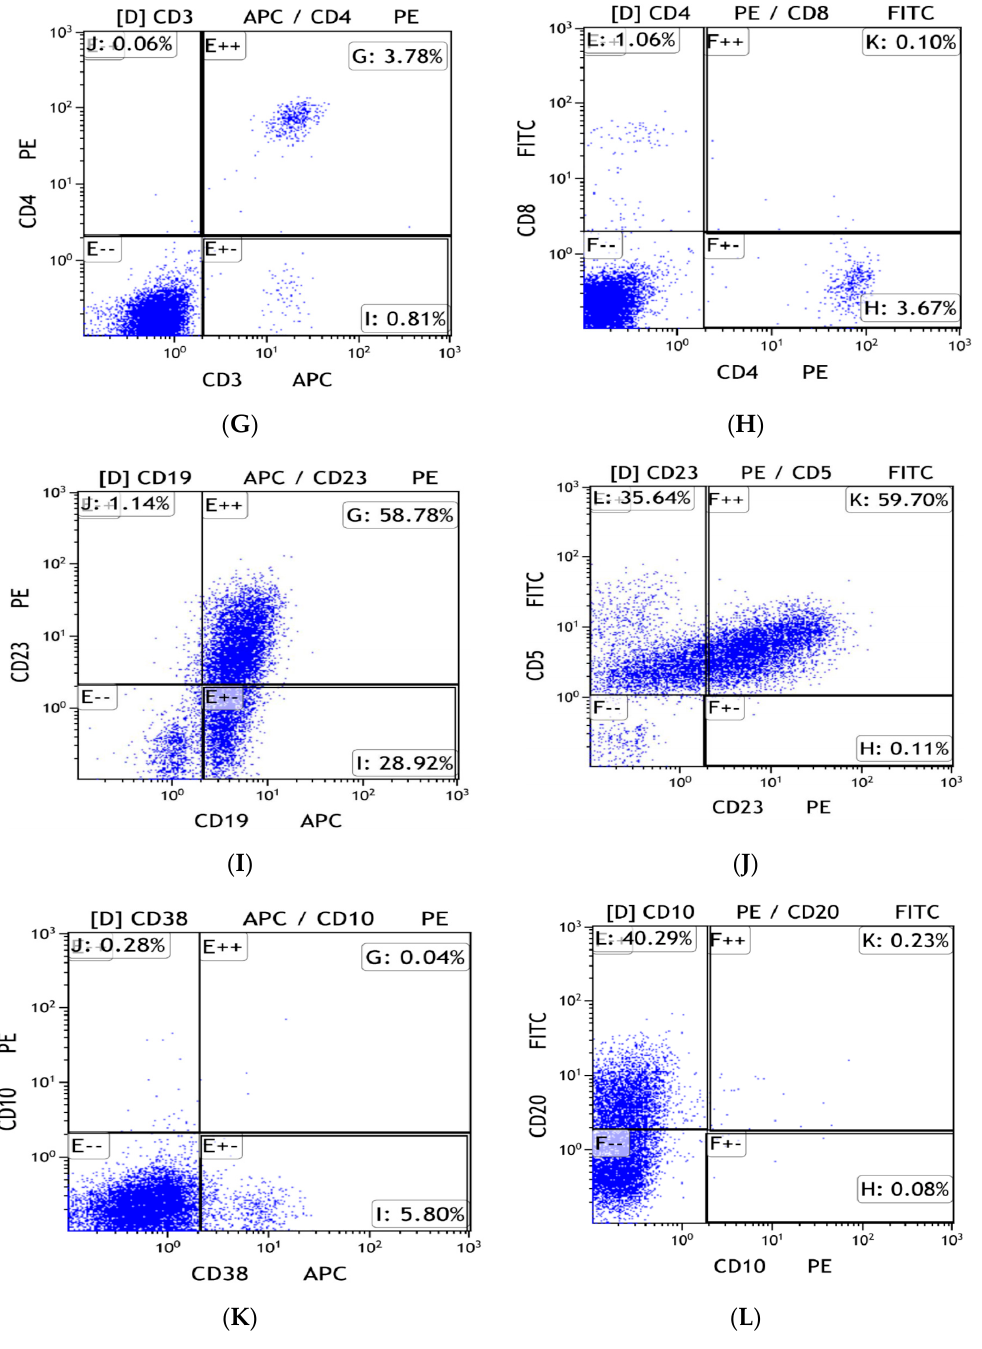
Figure 5. ( A – L ). Dot blot-based gating strategy for a proof-of-concept study of small lymphocytic